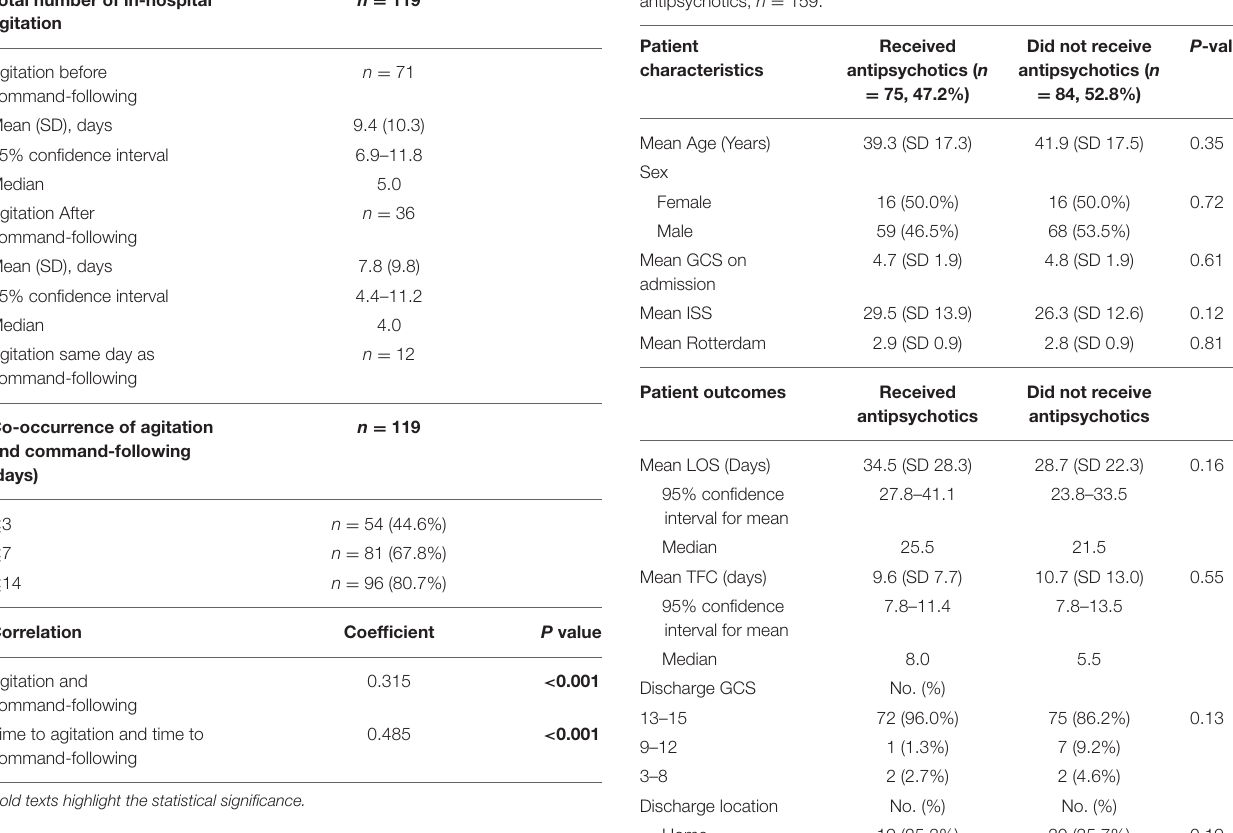
TABLE 4 | Comparing patient characteristics and clinical outcomes between patients who received antipsychotics for agitation vs. those who did not receive antipsychotics, n =